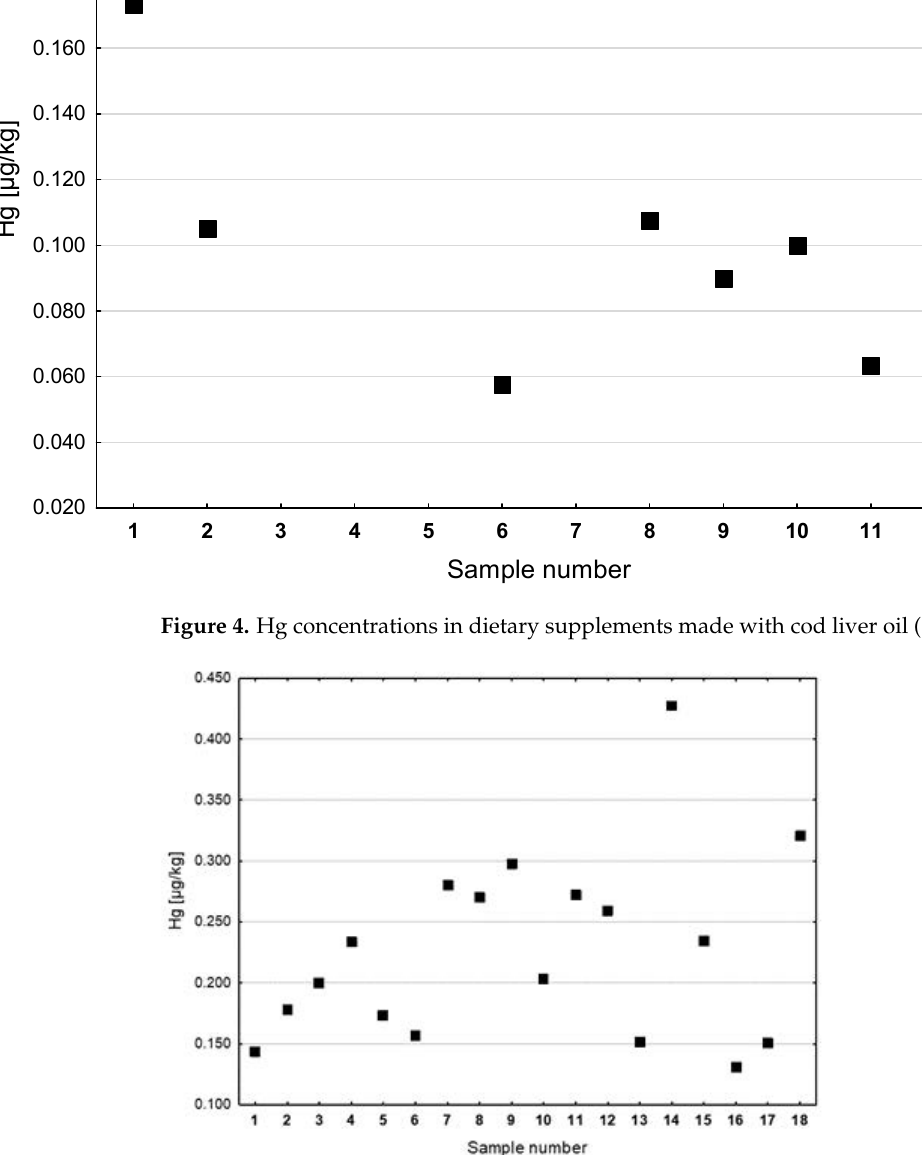
Figure 5. Hg concentrations in dietary supplements made with vegetable oil ( µ